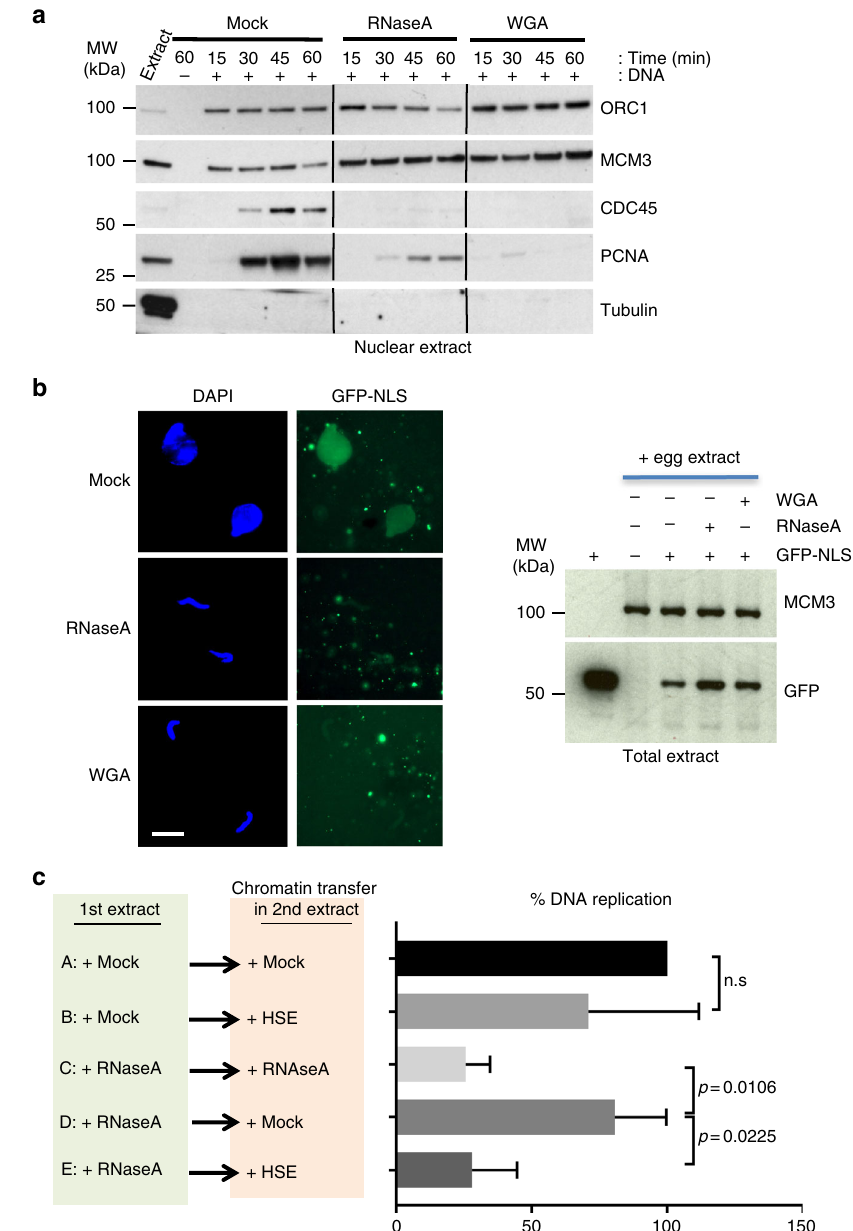
Fig. 4 RNAs are required for nuclear import mediated by functional nuclear envelope assembly. a Sperm nuclei were incubated in mock- and RNA-depleted extracts. At the indicated time points, nuclei were puri fi ed and nuclear extracts analysed by western blotting. The anti-tubulin antibody was used to monitor cytoplasmic contamination during nuclear extract preparation. Addition to the extracts of wheat germ agglutinin (WGA), which inhibits nuclear import, blocks accumulation of factors associated with replication activation and elongation (CDC45 and PCNA, respectively). b Sperm nuclei were incubated in egg extracts supplemented with GFP-NLS (green) to monitor nuclear import. Its accumulation into nuclei (stained with DAPI) was monitored with an epi fl uorescence microscope. Scale bar, 15 μ m. GFP-NLS level in each condition was assessed by western blotting analysis of total extracts. MCM3 was used as loading control. c Chromatin was assembled in mock- or RNase A-treated LSE (for 20 min) and then transferred to a mock- or RNAse A- treated LSE, or to a HSE, which lacks membranes. The graph shows the percentage of DNA replication at 120 min after transfer to the second extract ( n = 3). Error bar shows the SD. P -values were determined by using a two-tailed Student ’ s t